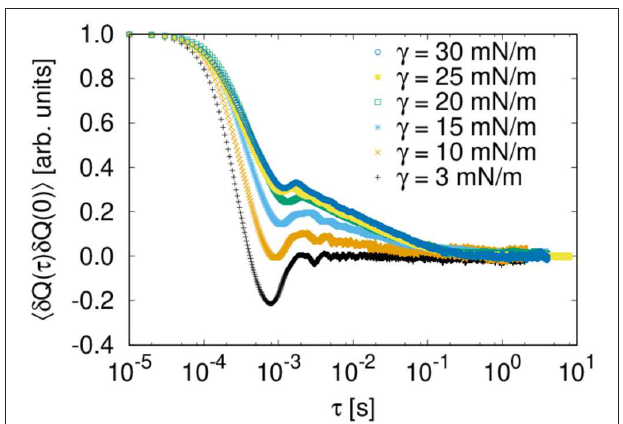
FIGURE 6 | Dependence of (scaled) time correlation function h Q ( τ ) Q (0) i on the surface tension γ (case (A) with 1 P /1 x = 100 kPa/m and network size of 30 × 20 links).